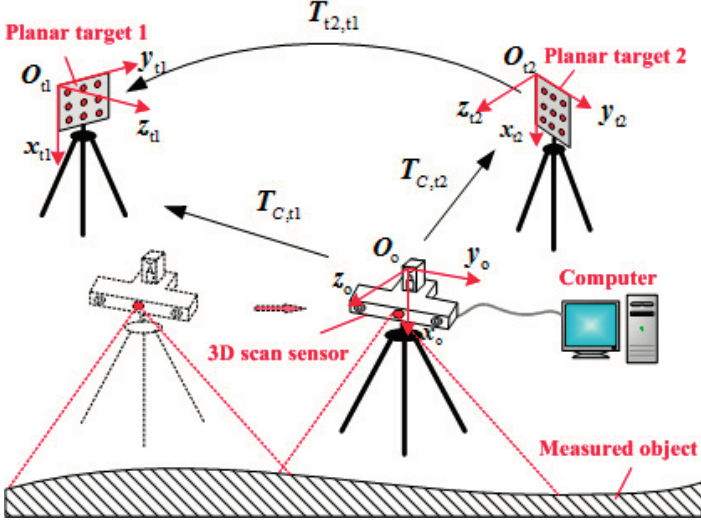
Figure 1. The structural schematic of the measurement